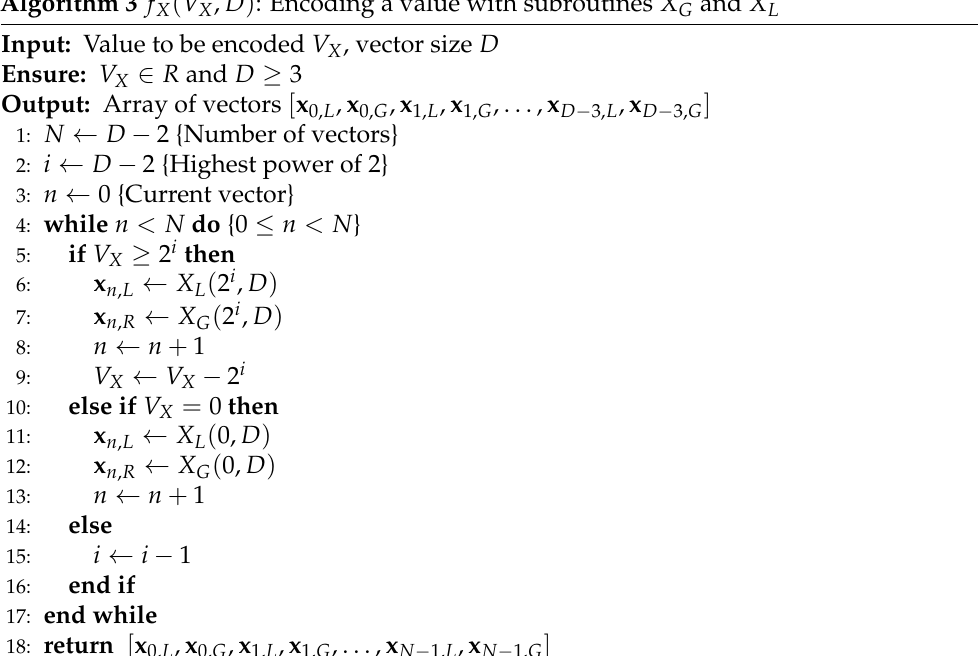
Algorithm 3 f X ( V X , D ) : Encoding a value with subroutines X G and X